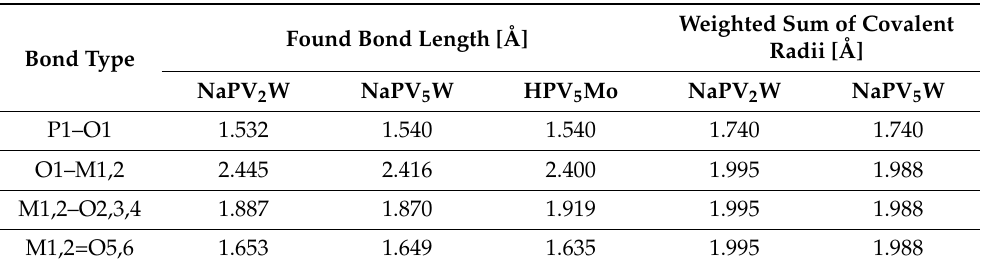
Figure 5. Solid-state structure of compound NaPV 5 W, determined by X-ray diffraction. The compound was crystallised in the space group P4/mnc (128). Residual electron density attributed to hydration water has been refined with a solvent mask (SQUEEZE). R 1 : 2.64%, wR 2 : 6.46%, R int : 5.86%, GooF: 1.032. Colour code: purple: phosphorous, red: oxygen, and blue: metals (W, V). Table 3. Found bond lengths vs. weighted sum of covalent radii of the obtained single ‐ crystal structures. Values for compound HPV 5 Mo were taken from Poller et al. [35].